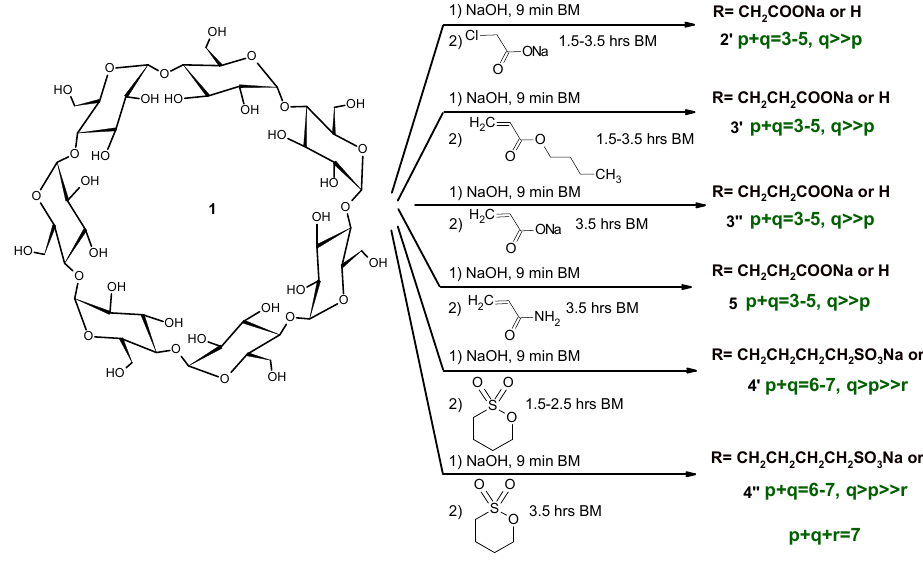
Scheme 2. Synthesis of anionic β CD derivatives with high-energy ball milling